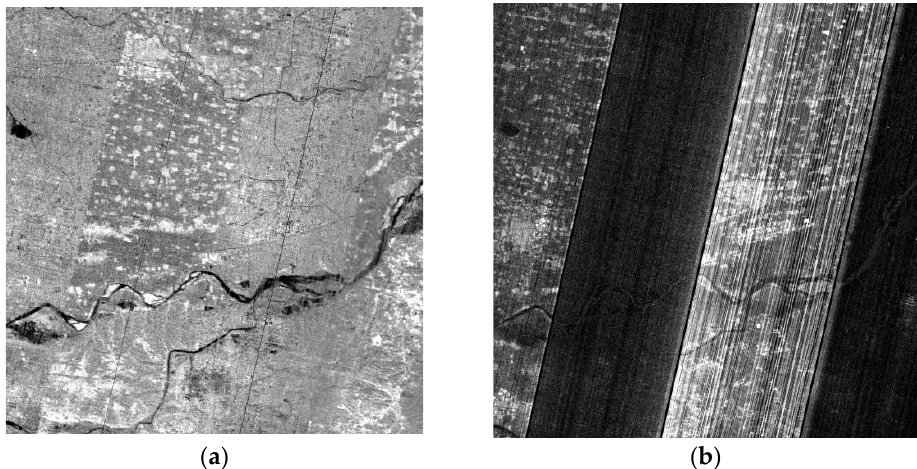
Figure 1. Examples of defects in ZY1-02D hyperspectral data. ( a ) Band 129 (1880.13 nm), ( b ) band 166 (2501.08 nm).